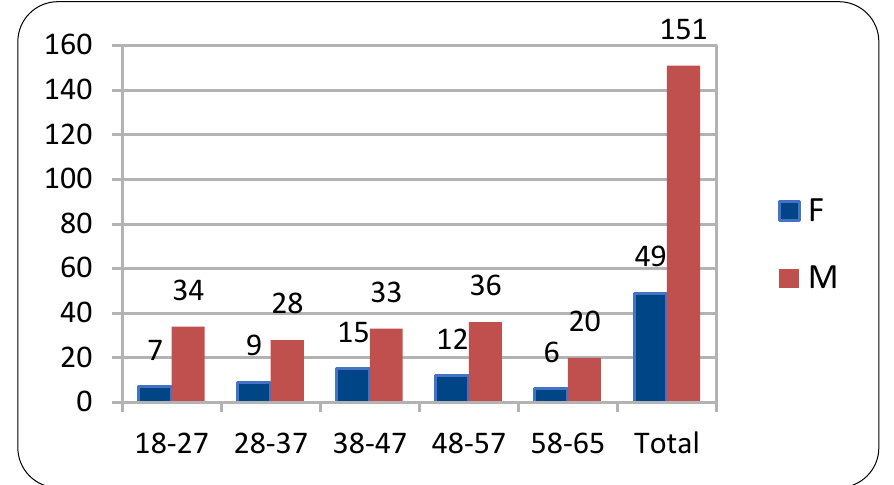
Figure 1. Sample distribution by age groups and sex.